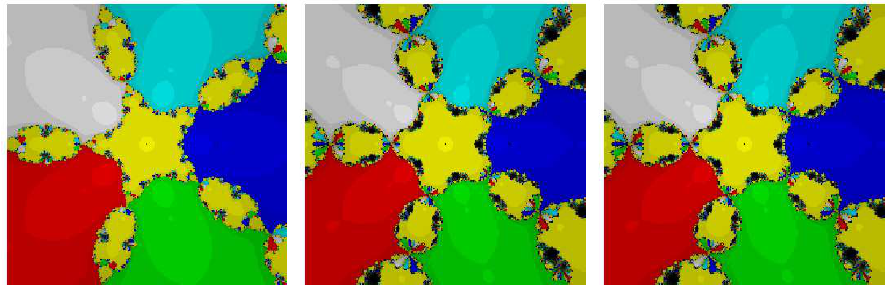
Figure 3. The methods M 1 , M 2 and M 3 , respectively for test problem